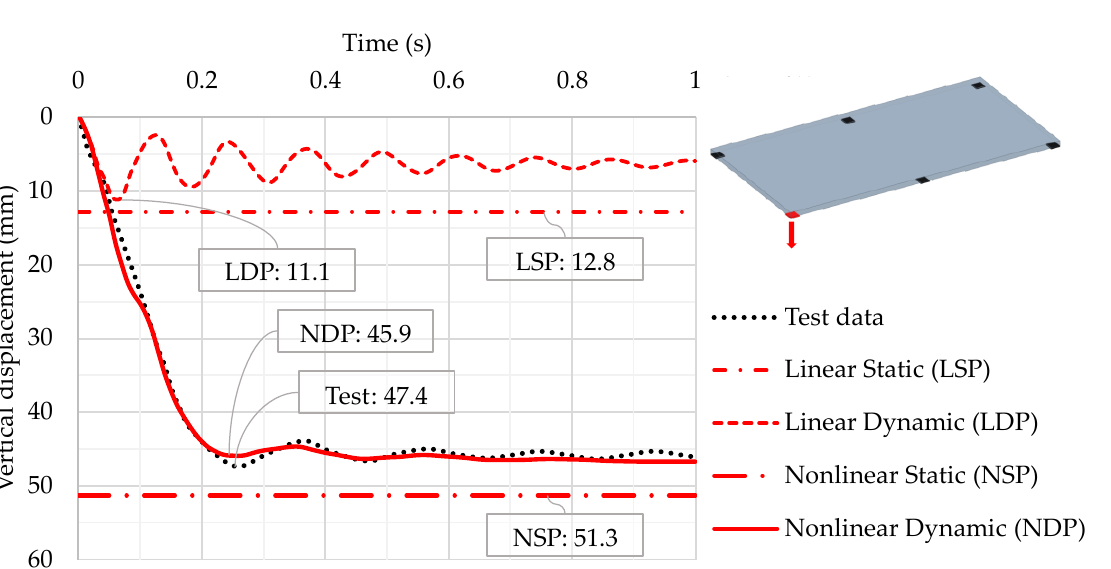
Figure 6. Comparison of damage accumulated in the flat slab from nonlinear dynamic ( a ) and nonlinear static ( b ) analyses with the crack patterns from the experiment.